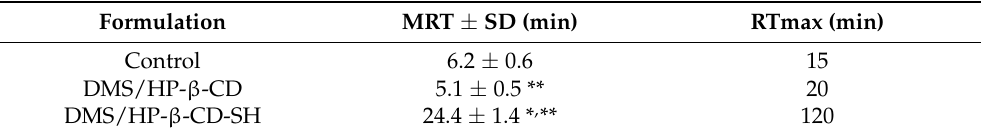
Table 1. Effects of CDs on DMS residence time in tear fluid of rabbits after instillation of one ophthalmic drop (50 µ L) containing 0.3% w/v DMS and 12.5% w/v of different CDs. MRT, mean residence time; RT max , maximum residence time at measurable concentrations ( ≥ 2.5 µ g/mL) ( n = 6).